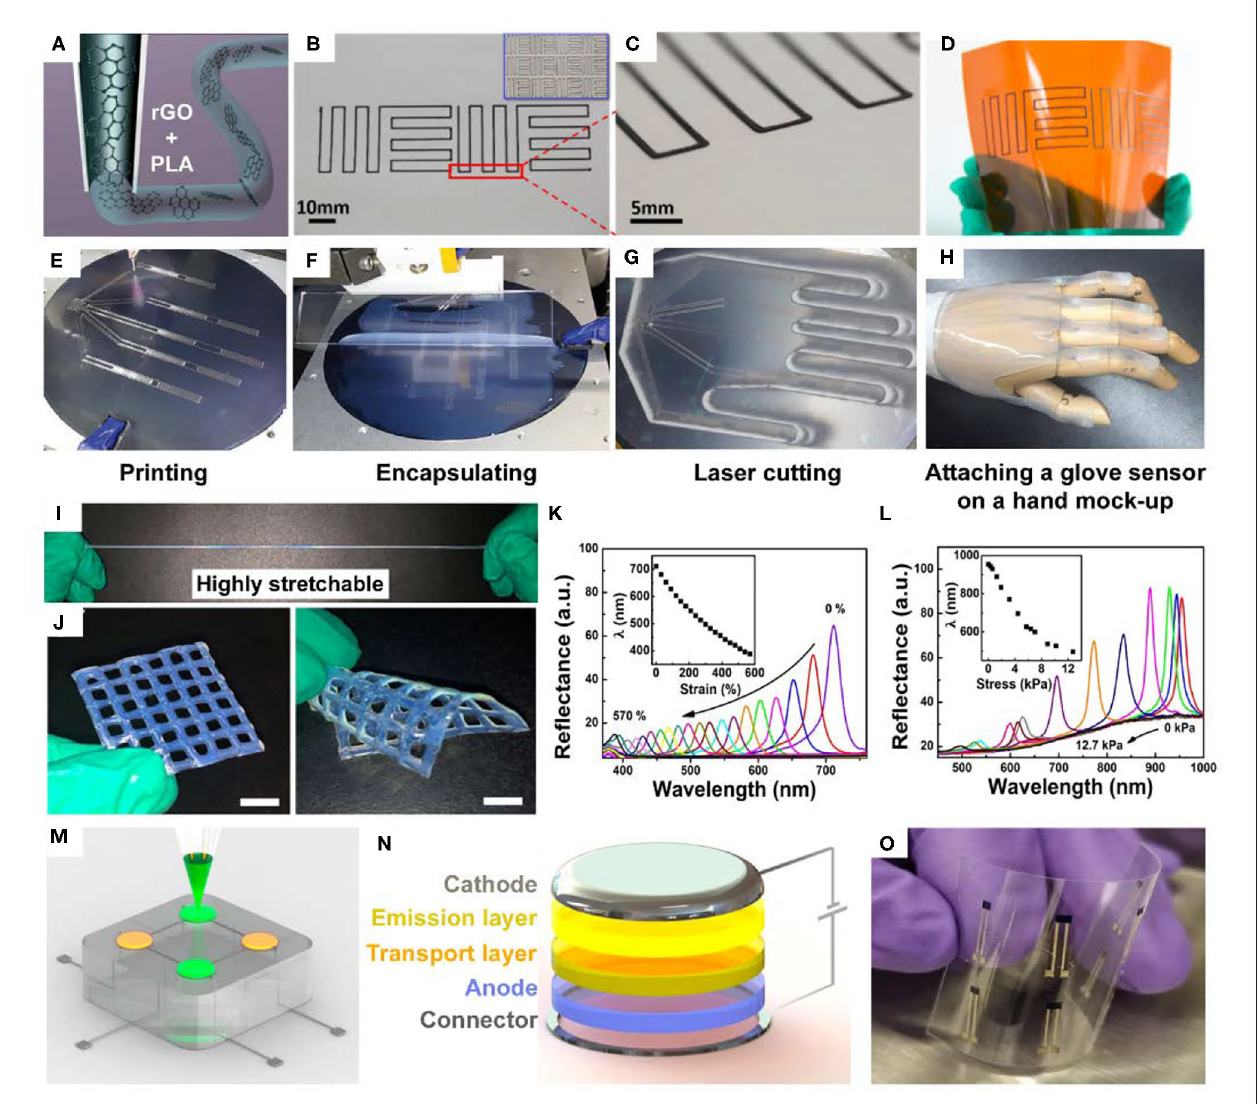
FIGURE 2 | (A) Schematic of printing circuits with the rGO/PLA composite ink. (B,C) Printed paper-based flexible circuits. (D) Printed polyimide-based flexible circuits. Reproduced from Zhang et al. (2016) with permission from Elsevier. (E–H) Fabrication process of a glove-type sensor. Reproduced from Kim et al. (2018) with permission from Mary Ann Liebert Inc. (I) Highly stretchable photonic crystal hydrogel. (J) Printed flexible photonic crystal hydrogel grid. (K,L) Normal incident reflectance spectra of photonic crystal hydrogel under different tensile strains (K) and compressive stresses (L) . Insets: tensile strain (K) and compressive stress (L) dependence of maxima ( λ ). Reproduced from Chen J. et al. (2019) with permission from American Chemical Society. (M) DIW-printing QDLEDs. (N) Layer-by-layer schematic of the QDLED components. Reproduced from Kong et al. (2014) with permission from American Chemical Society. (O) Printed PET-based flexible OECTs. Reproduced from Fan et al. (2019) with permission from